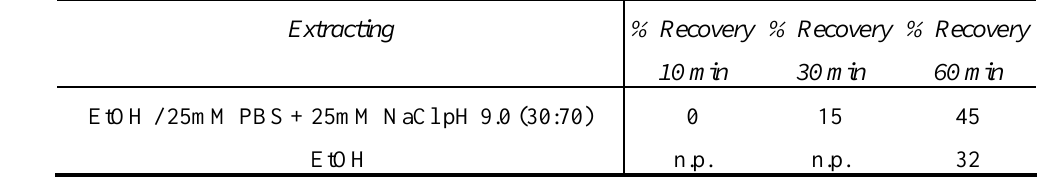
n.p. not performed. Table 3. % recovery of the extraction of AT with ultrasounds probe with different solvents and times calculated trough UV spectroscopy.